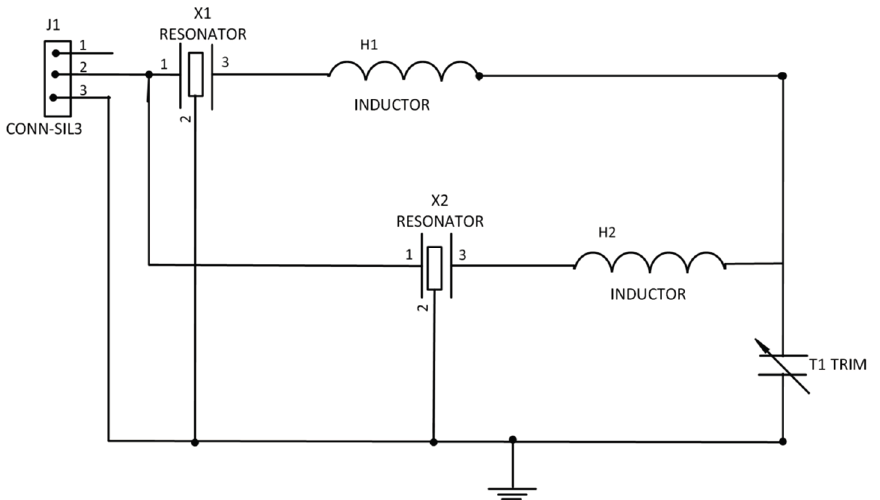
Figure 1. Schematic of DSAWR